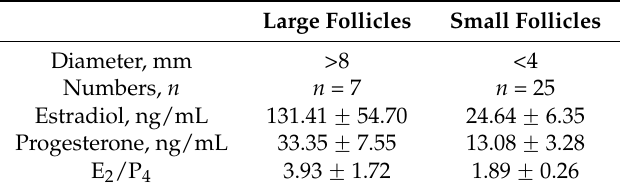
Table 1. Follicles concentrations of estradiol and progesterone and ratios of E 2 /P 4